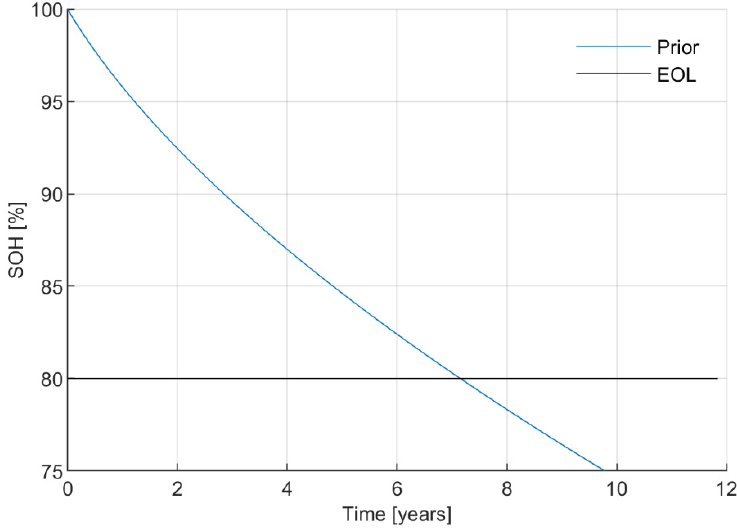
Figure 4. Example of the aging evolution of a battery system.